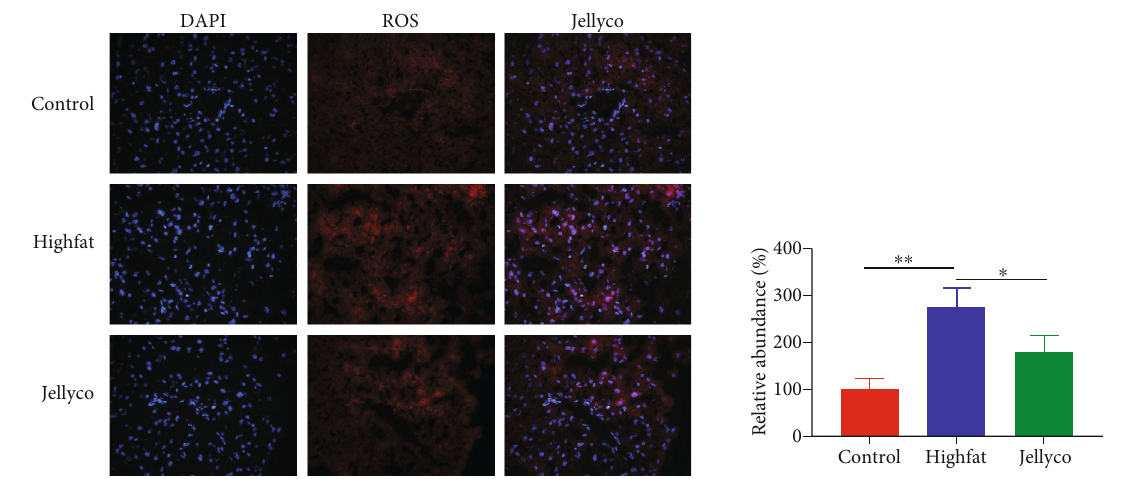
Figure 3: Jelly fi sh collagen hydrolysate prevented hepatic ROS accumulation in high-fat diet-fed mice. Data are expressed as means ± SEM , n = 3 . ∗ P < 0 : 05 , ∗∗ P < 0 : 01